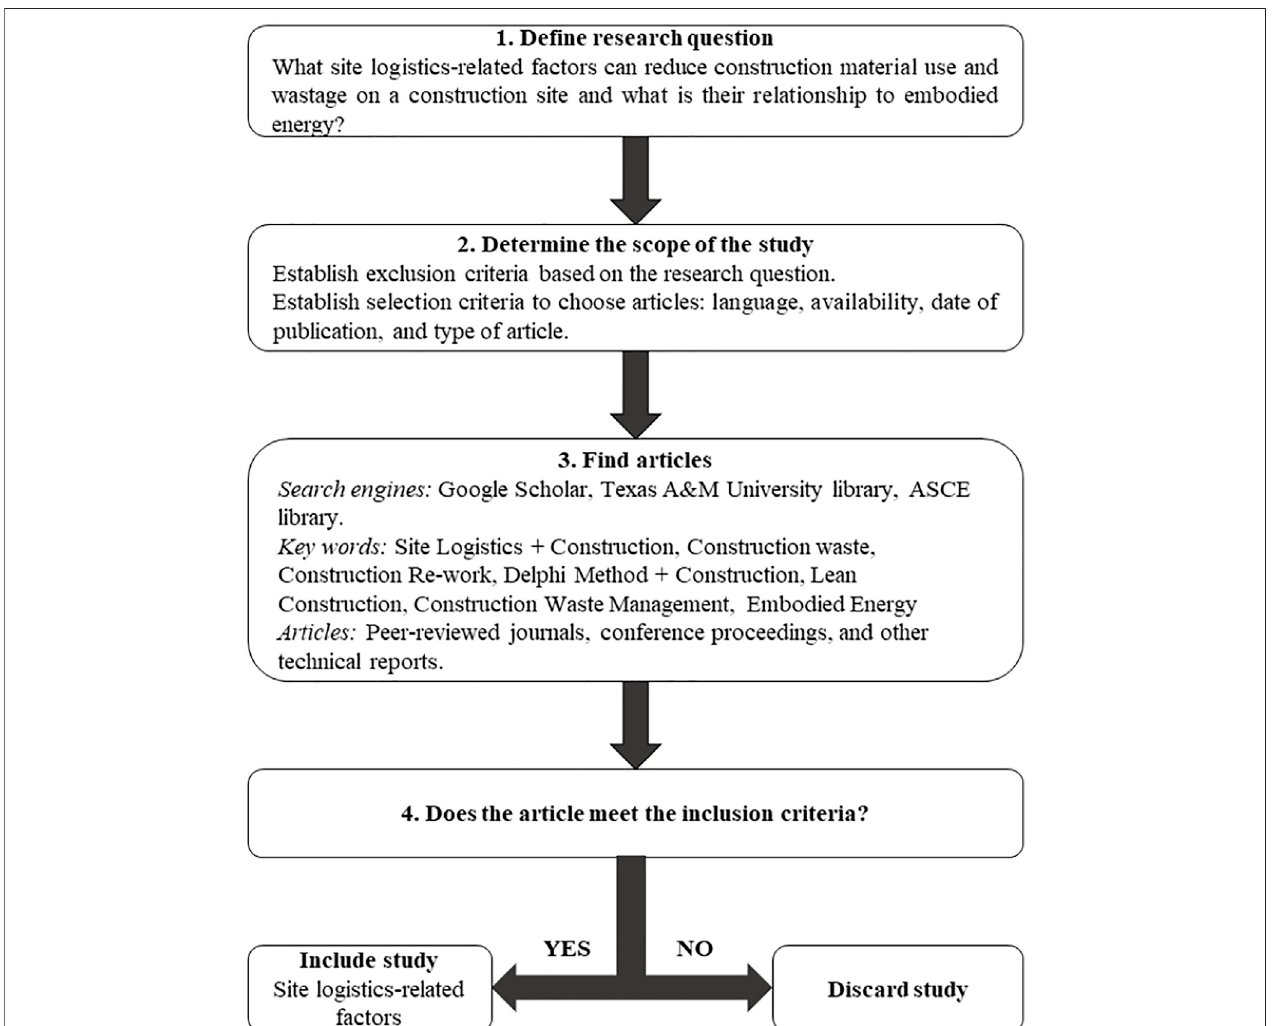
FIGURE 1 | Systemic literature review framework (adopted from Hurwitz et al., 2016).